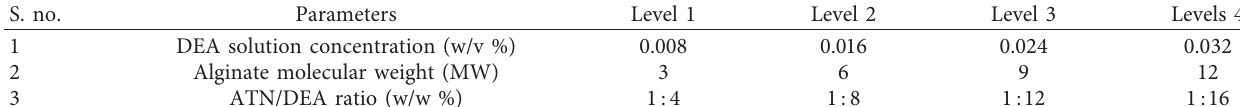
Table 1: Process parameters and their levels for Taguchi L16 experimental